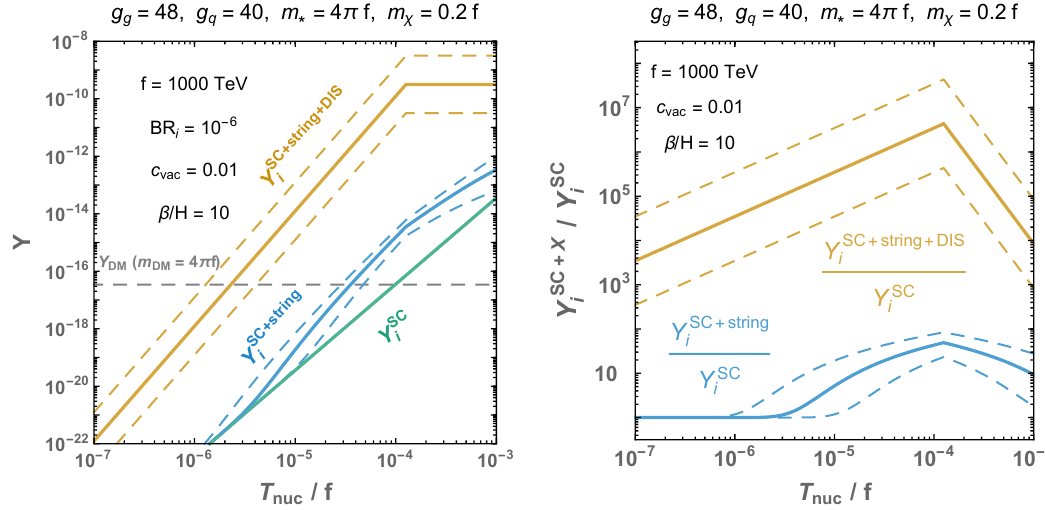
Figure 8 . Left: the yields following supercooling eq. (9.3), string fragmentation eq. (9.2) and deep inelastic scattering eq. (9.1). The yield matching the observed relic abundance of DM for = 4 π f is also shown. The dashed lines show the effect of varying γ m DM in either direction around eq. (5.1). This illustrates the sensitivity of the yield to our determination of γ . Right: ratios of the same yields. The peak corresponds to the maximum γ wp